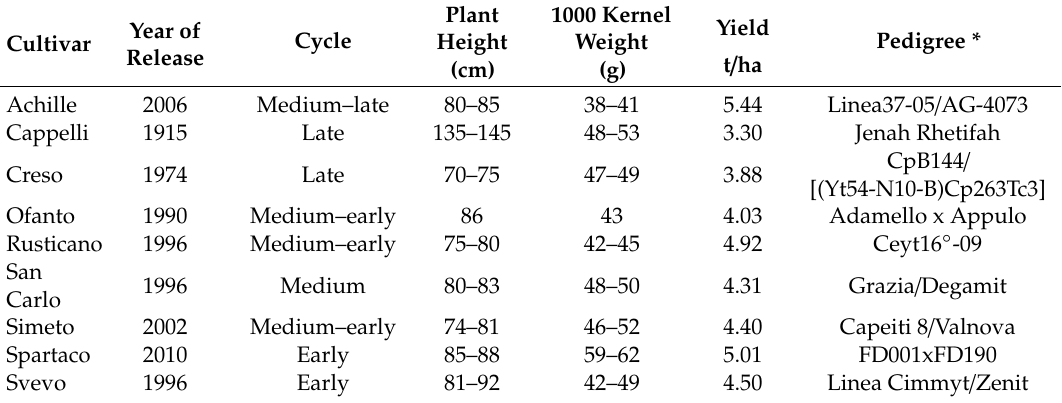
Table 1. List of the nine durum wheat cultivars examined in this study. Specific parameters characterizing the single varieties are reported: cycle, plant height (cm), 1000-kernel weight (g), yield (t / ha), and parental